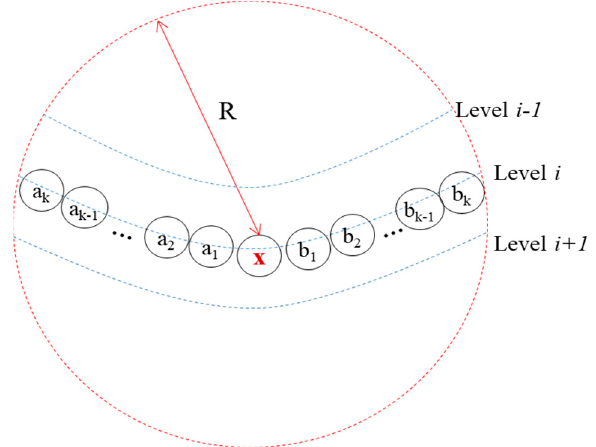
Figure 7. The maximum number of competing nodes at any tree level.